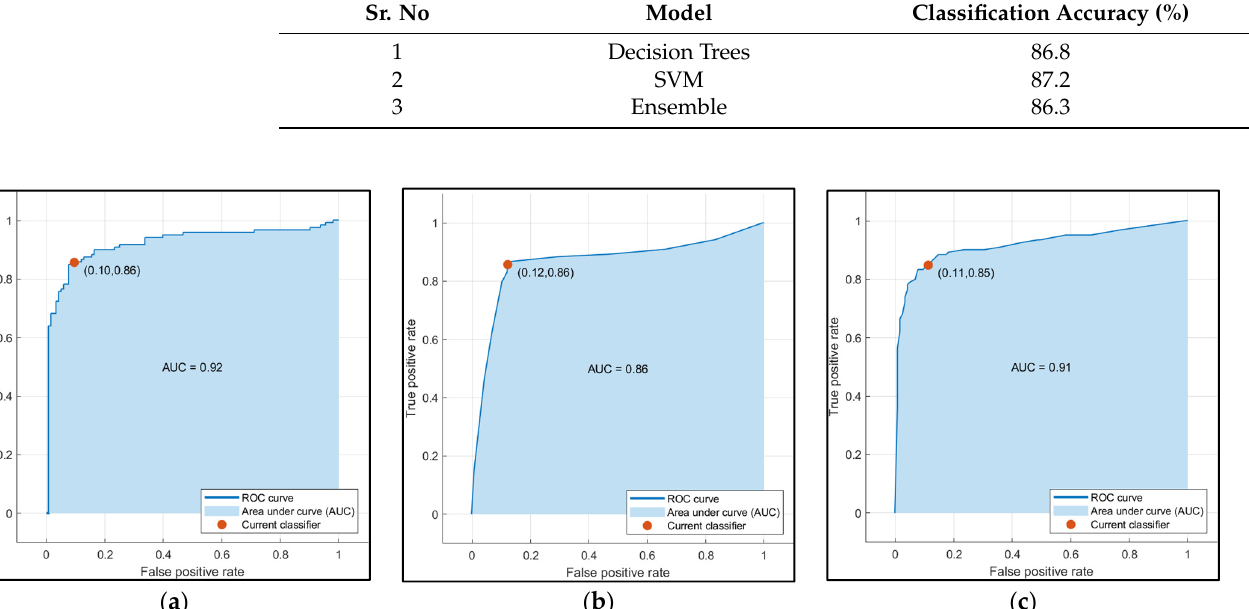
Table 4. Classification accuracy based on structural data of the subjects. Sr. No